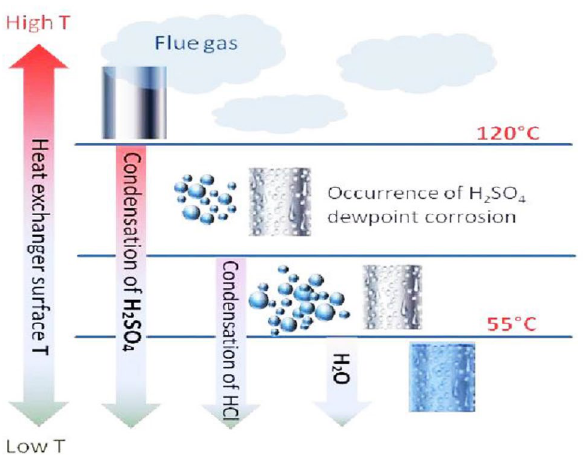
Figure 1. A schematic illustration of “dew point corrosion” mechanism in heater exchangers 8 .